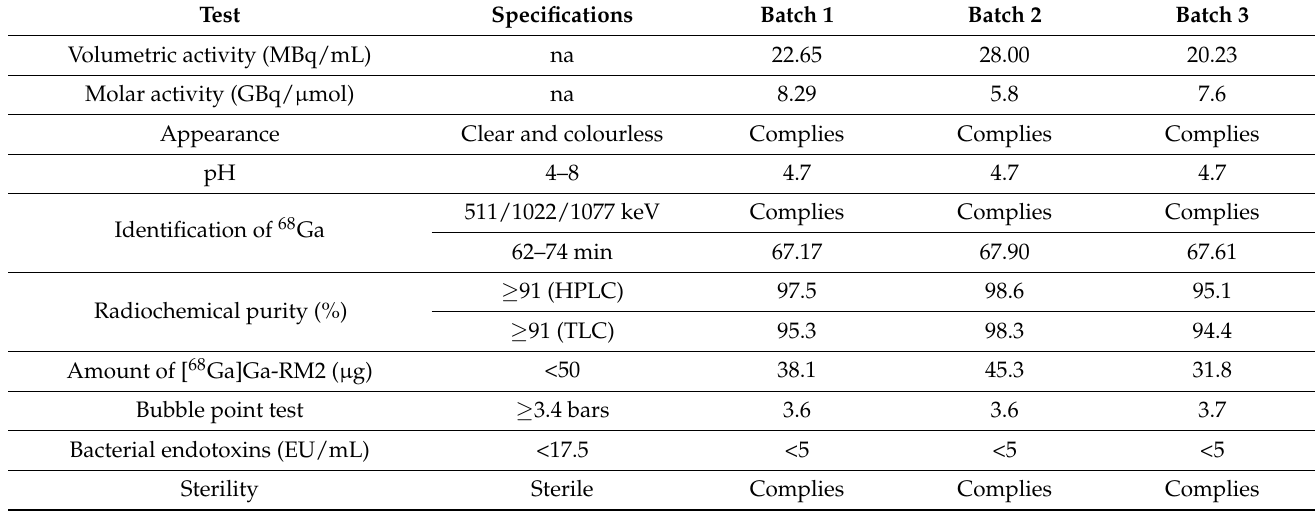
Table 1. Validation batches of [ 68 Ga]Ga-RM2 obtained from the kit developed in this study.